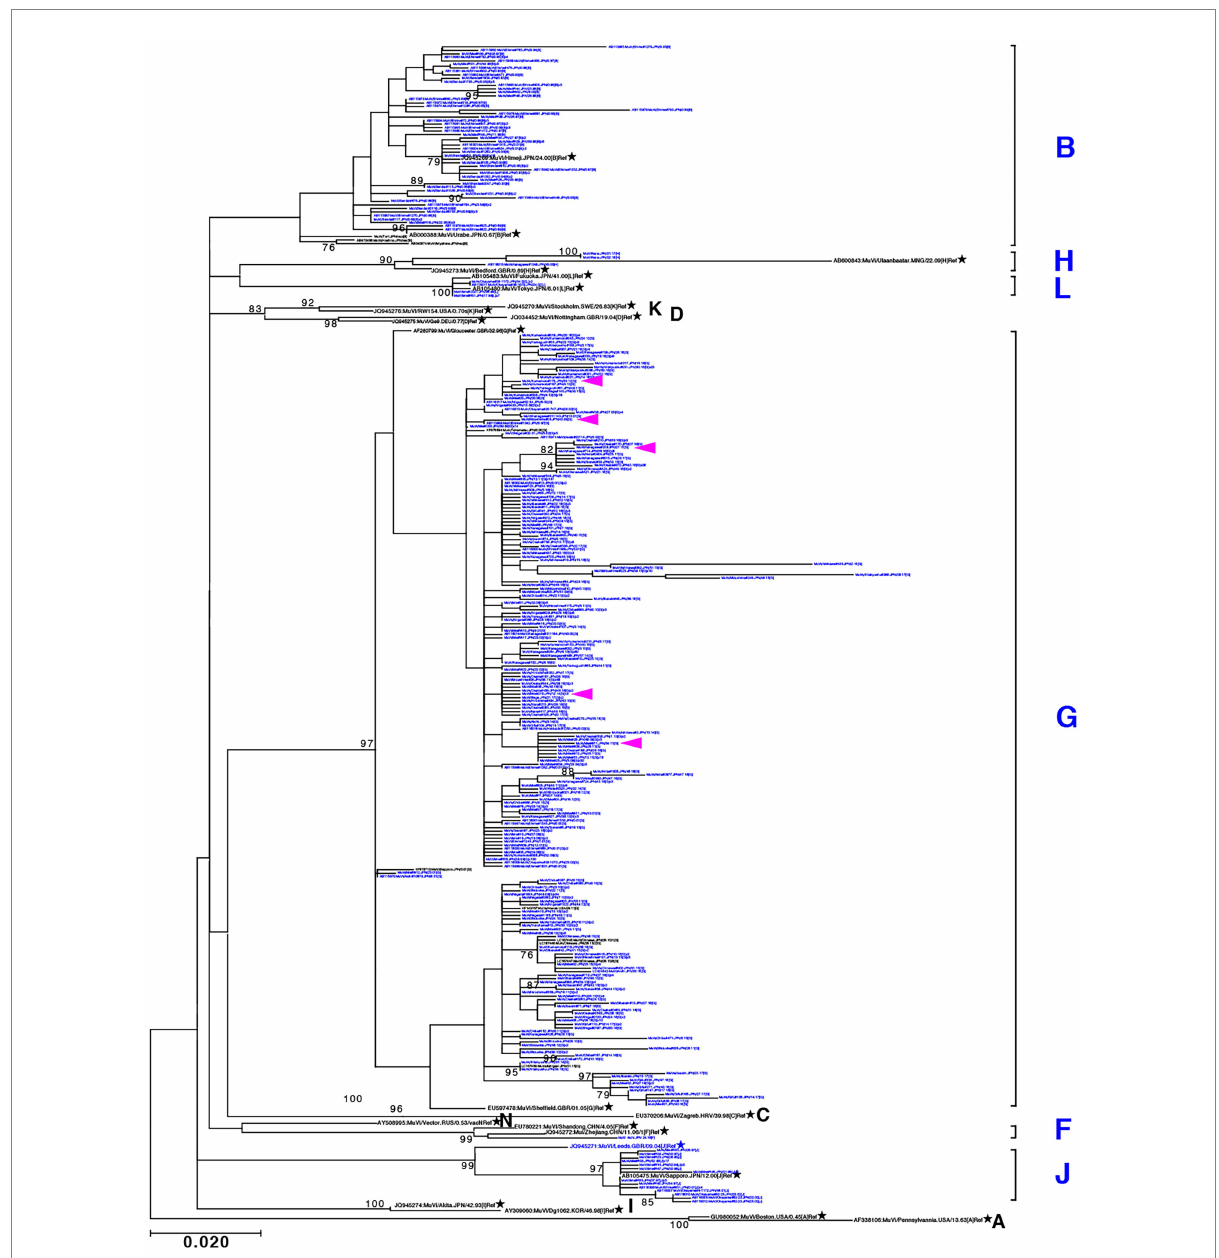
FIGURE 3 Maximum-likelihood phylogenetic tree inferred by SH gene sequence data of mumps virus (MuV) isolates identified in this study, the World Health Organization (WHO) reference strains, and related strains obtained from Data Bank of Japan (DDBJ). MuV strains obtained in this study are indicated by blue letters. WHO reference strains are indicated by black letters and marked with stars ( ★ ). Related strains are indicated by black letters. Bootstrap values >75% are indicated on the trees. Alphabets A to N indicate the genotypes of MuVs proposed by WHO; the six genotypes shown on the right side in blue letters are the genotypes identified in this study. Genotype A reference sequences were employed as the outgroup. Magenta arrow-heads denote the strains harboring the SH genes with truncated open reading